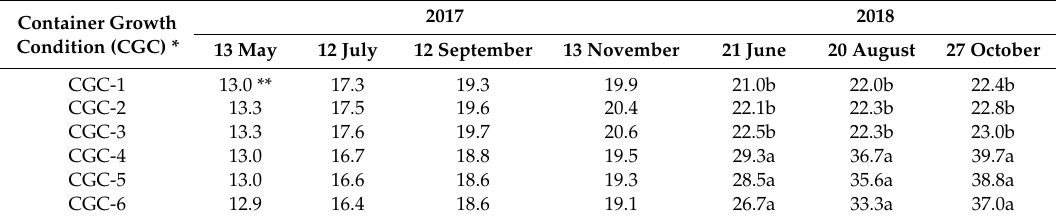
Table 4. Height (cm) a ff ected by container growth conditions of Pinus densiflora